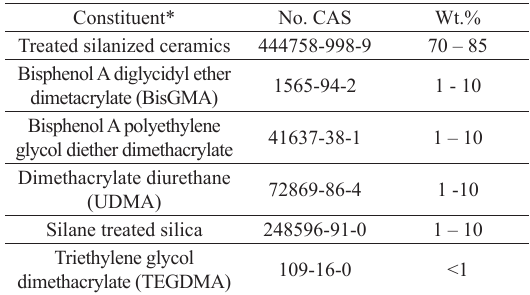
Table 1. Composition of Filtek Z250 XT resin.